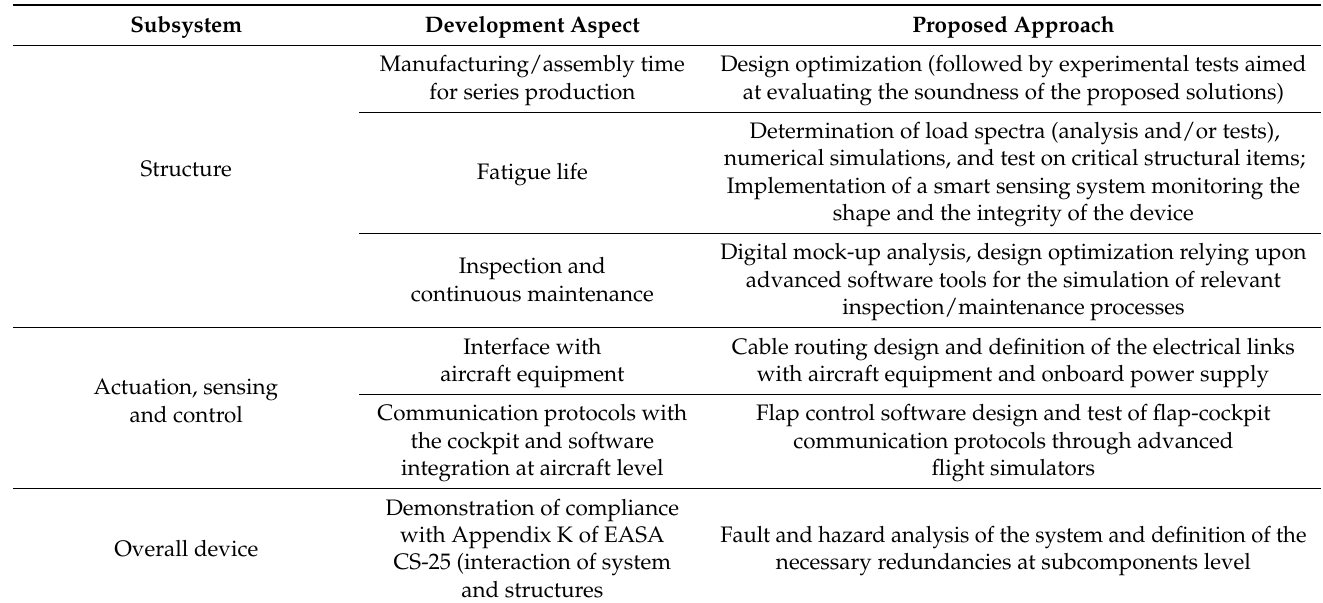
Table 2. Morphing flap, Impacted development aspects and proposed